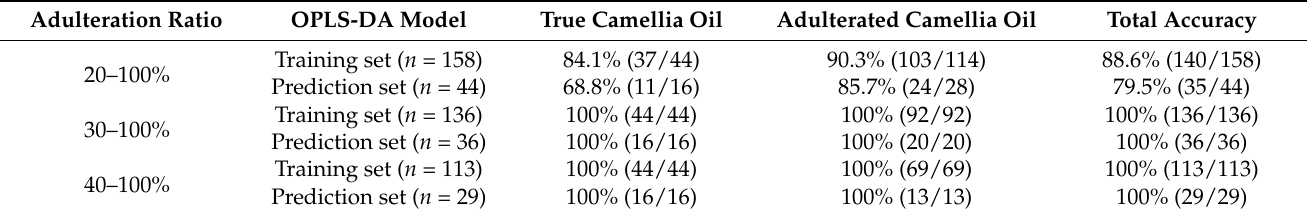
Table 3. Discrimination accuracy of the